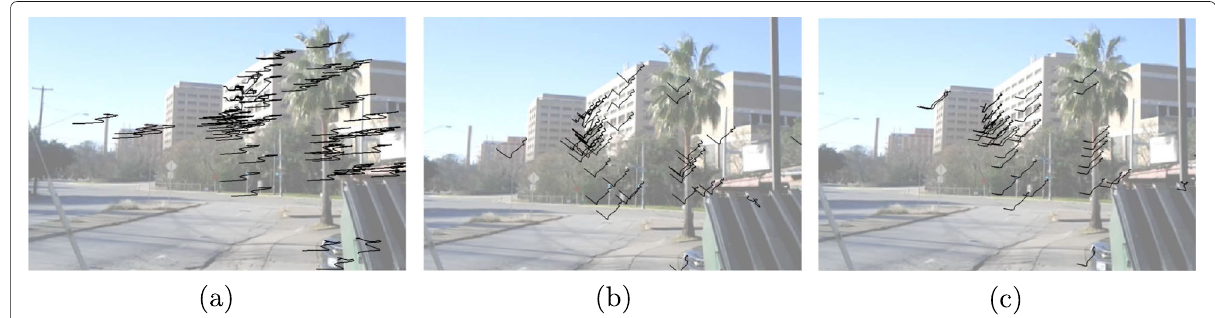
Fig. 14 Stabilization comparison for video 1. Features are tracked from frame 700 to frame 719. The feature tracks are plotted as blackcurves on frame 700. a Constrained KF with small σ p . b Constrained KF with large σ p . c Constrained IMM